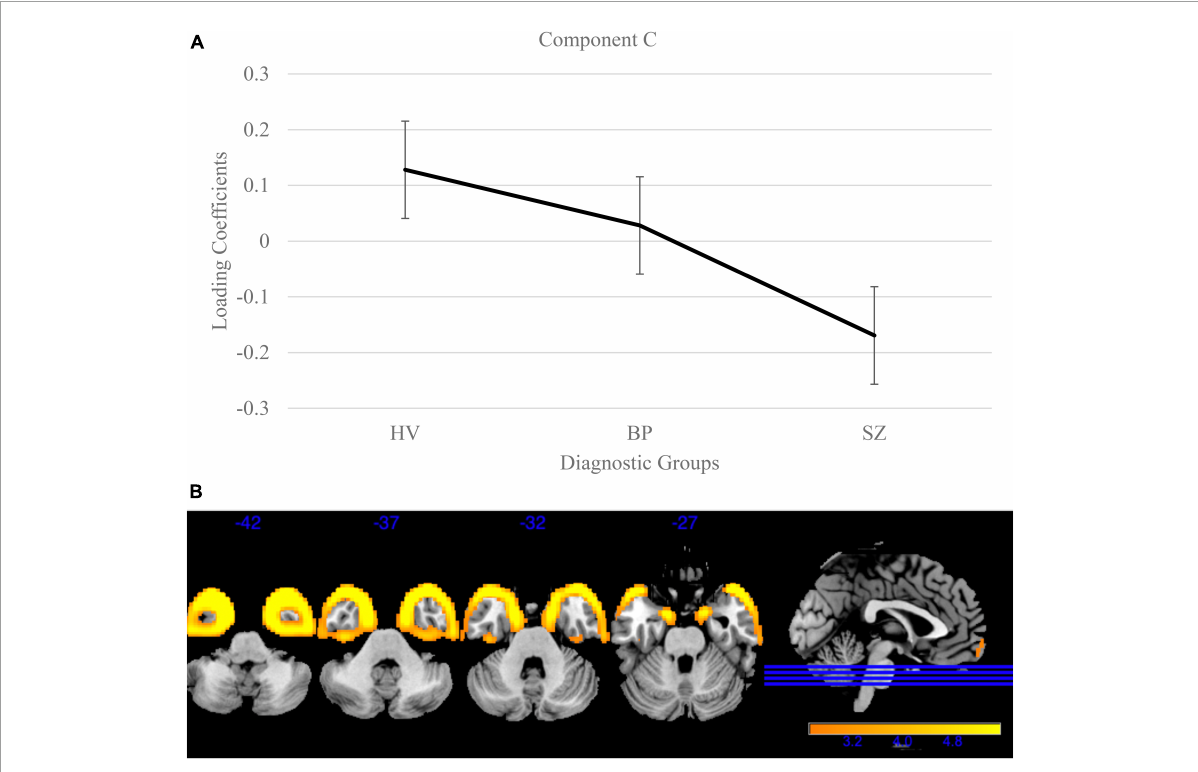
FIGURE3 Temporal pole gray matter group differences in independent component analysis (ICA) results for healthy volunteers, individuals with schizophrenia, and individuals with bipolar I disorder. (A) Group effects of diagnosis on loading coefficients. Individuals with schizophrenia (SZ) had significantly less gray matter compared to individuals with bipolar disorder (BP) and healthy volunteers. Individuals with BP did not differ significantly from healthy volunteers. (B) Component C showed less gray matter concentration in the bilateral temporal poles in individuals with SZ compared to individuals with BP and healthy volunteers. Individuals with BP did not significantly differ from healthy volunteers. Images are thresholded at